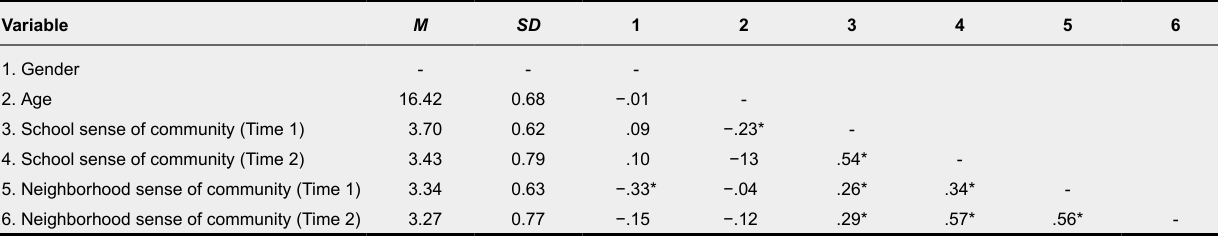
Correlations Among and Descriptive Statistics for Key Study Variables